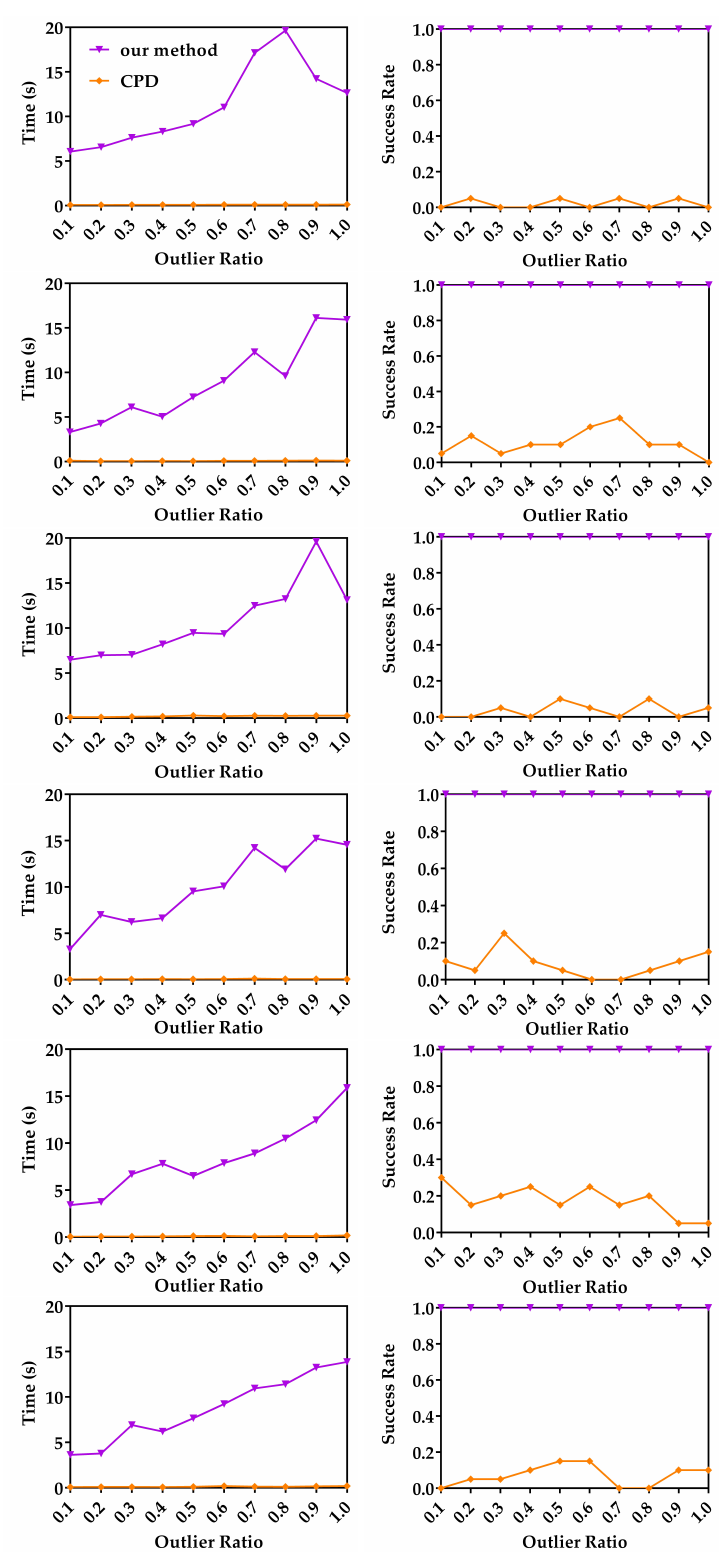
Figure 3. Median runtime and success rate with respective to the outlier ratio. Random data (first row), Archer (2nd row), Chef (3rd row), Kids (4th row), Lucy (5th row) and Owl (last row). Left column: The median runtimes of our method and CPD with respect to the outlier ratio. Right column: The mean success rates of our method and CPD with respect to the outlier